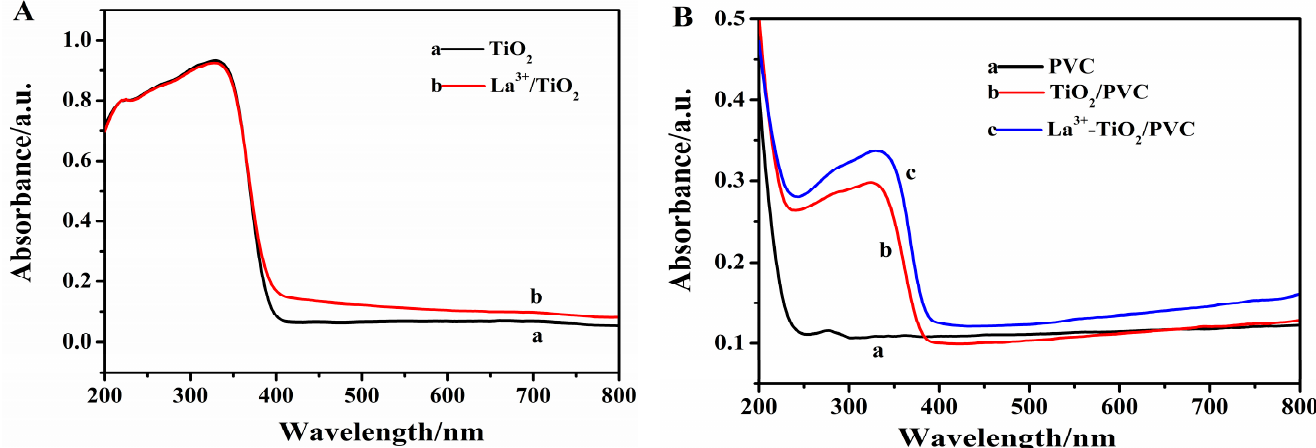
Figure 4. UV-visible absorption spectrum. ( A ) (a) TiO 2 (b) La 3+ /TiO 2 ; ( B ) (a) Pure PVC sample, (b) TiO 2 /PVC sample, (c) La 3+ /TiO 2 /PVC sample.